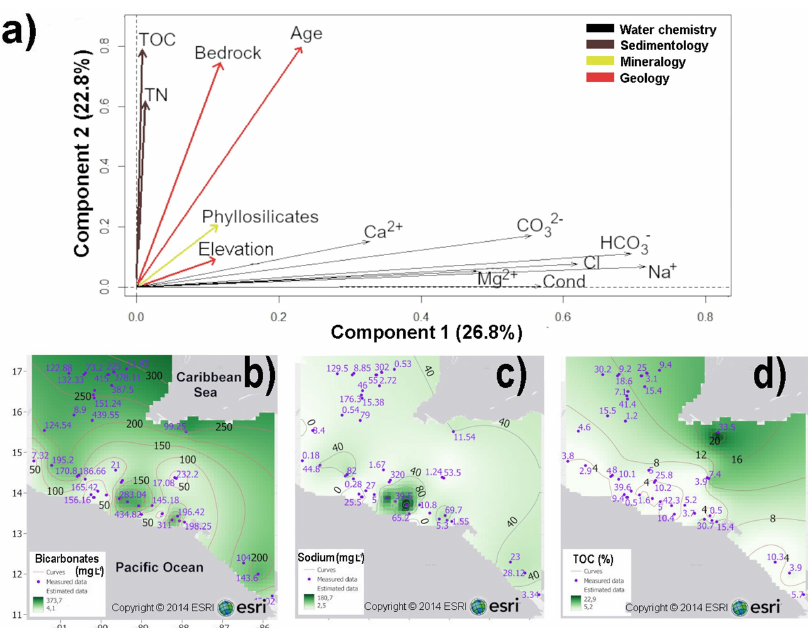
Figure 4. (a) PCA biplot based on 13 variables from 31 aquatic ecosystems of central–southern Guatemala, El Salvador, Honduras and Nicaragua (GSHN limnological region). Ionic composition of HCO 3 − , Na + , and Cl − were the most meaningful variables characterizing aquatic ecosystems, as they explain 26.8% of the total variance. Sediment geochemistry and geology were the second most important vari- ables, accounting for 22.8% of the total variance. Arrows represent variables. Spatial representations of meaningful variables are presented in (b–d) : interpolated maps of bicarbonates (b) ; sodium (c) ; TOC (d) . Abbreviations are as follows: conductivity (cond) (µScm − 1 ), mag- nesium (Mg 2 + ), sodium (Na + ), chloride (Cl − ), bicarbonate (HCO 3 − ), carbonates (CO 32 − ), calcium (Ca 2 + ), total nitrogen (TN), and total organic carbon (TOC). Major ion concentrations are expressed in mgL − 1 . Blue numbers in maps represent measured values, black numbers are interpolated